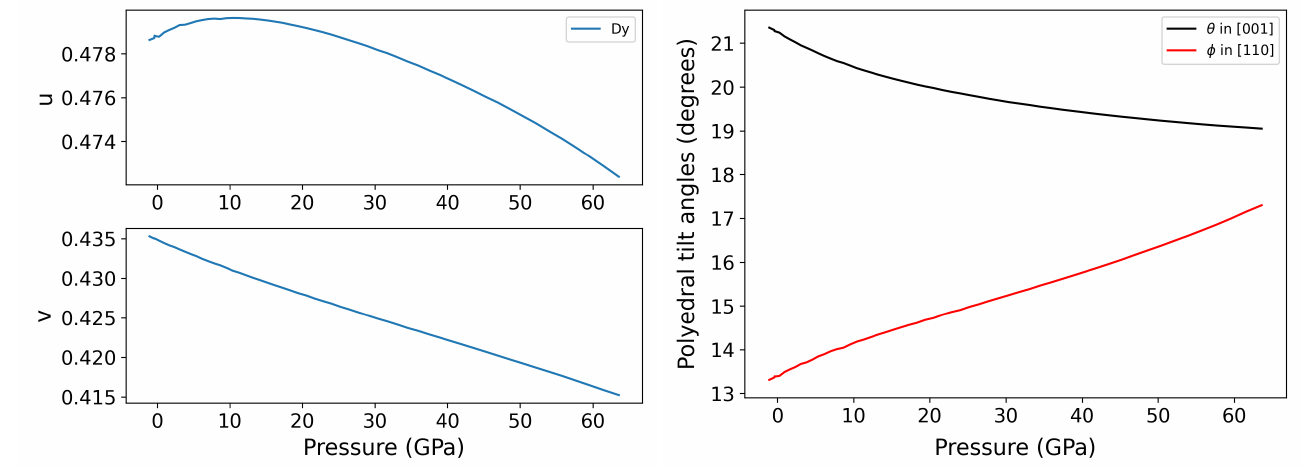
Figure 3. ( left ) Evolution of the internal parameters of the 4c Wickoff positions of Dy with pressure. (The values for the ideal cubic perovskite are ½, ½) ( right ) Tilt angles change with pressure.